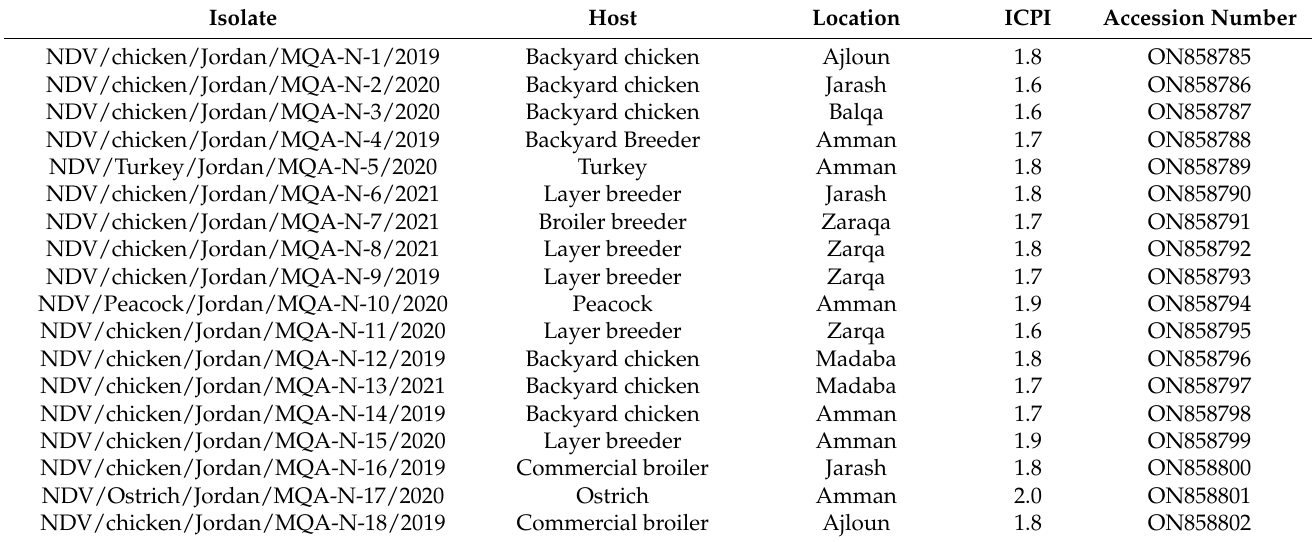
Table 1. Sampling data and prevalence of Avian Avulaviruses in different geographical regions in Jordan during